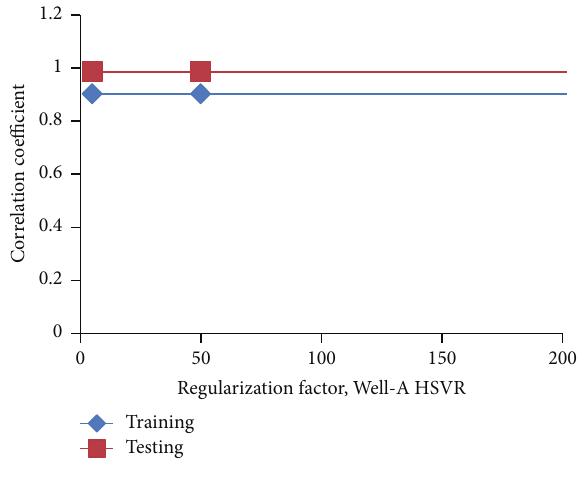
Figure 5: Sensitivity of HSVR model to regularization factor (Well- A).